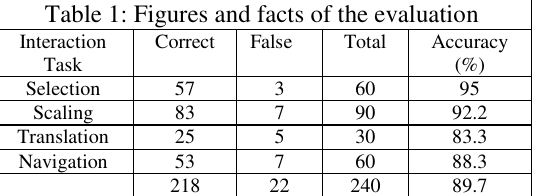
Table 1: Figures and facts of the evaluation